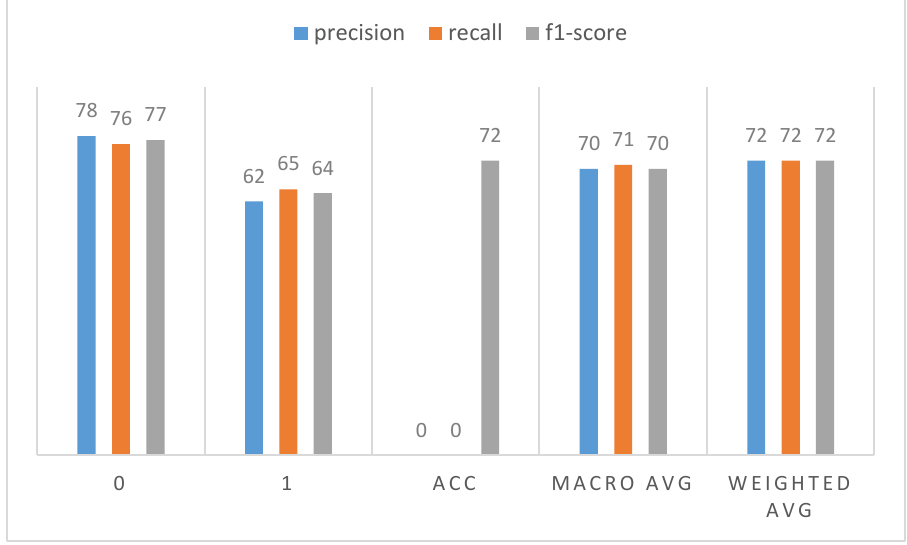
Figure 14. Summary of results for a testing dataset equal to 50% and training dataset of 50%.